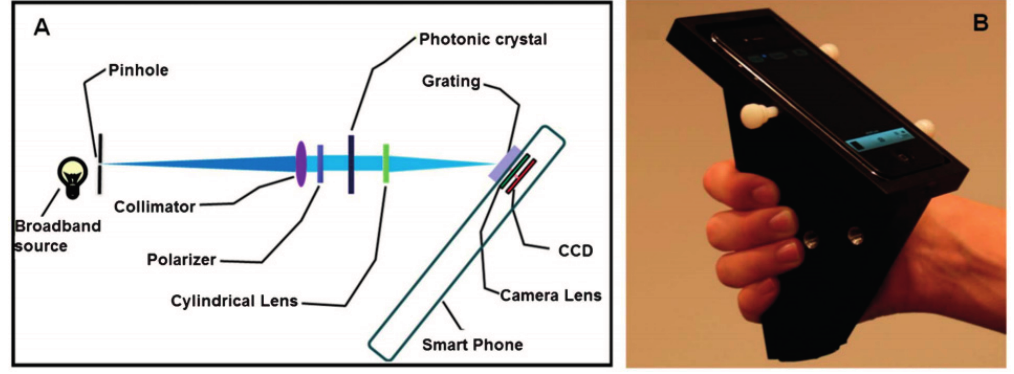
Figure 20. ( A ) Schematic of the optical components within the smartphone cradle. Broadband light from an external source (such as an incandescent lamp or LED) is collimated by the combination of an entrance pinhole and a collimating lens. After passing through a linear polarizing filter, light passes through the photonic crystal, which resonantly reflects one narrow band of wavelengths. The cylindrical lens increases the amount of light that is collected by the camera. ( B ) Photo of the cradle with a photonic crystal biosensor slide inserted into the detection slot (Reproduced with permission from